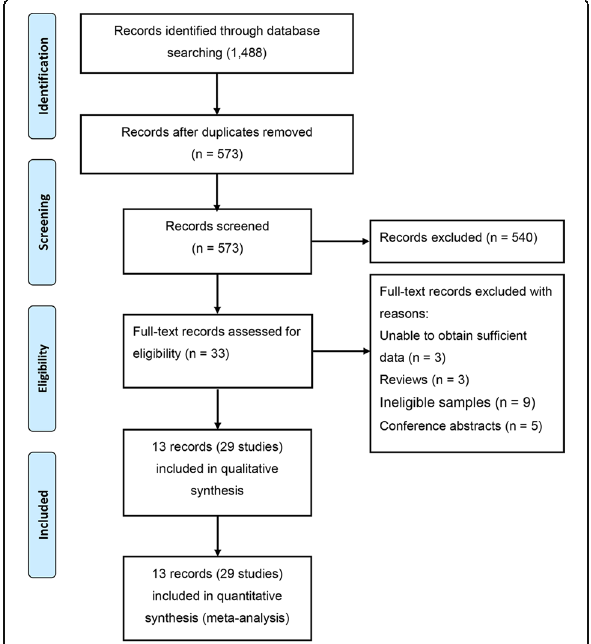
Fig. 1 Flow chart of the selection of eligible studies for the meta –